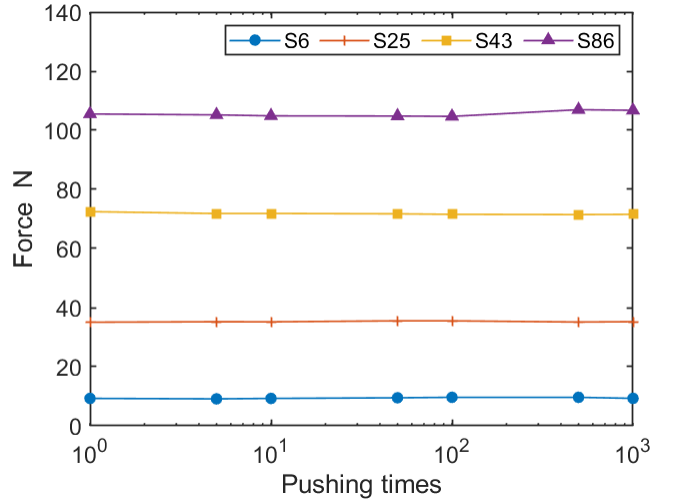
Figure 7. Representative force measured out of 1000 times by the four texture sensors.